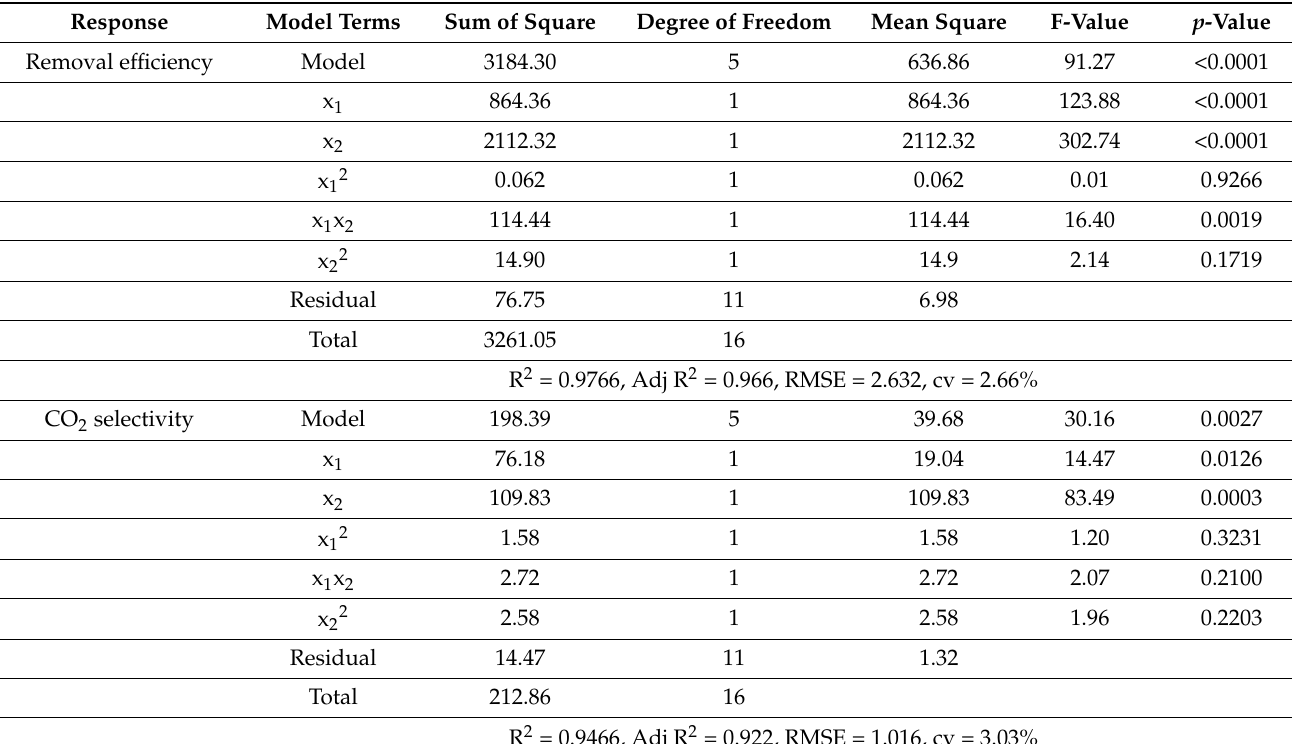
Table 3. The magnitude and significance analysis of factor effects on the